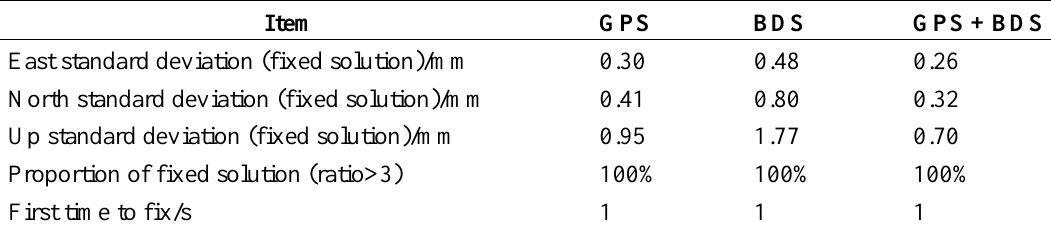
Table 2. Statistics of zero baseline experiment.